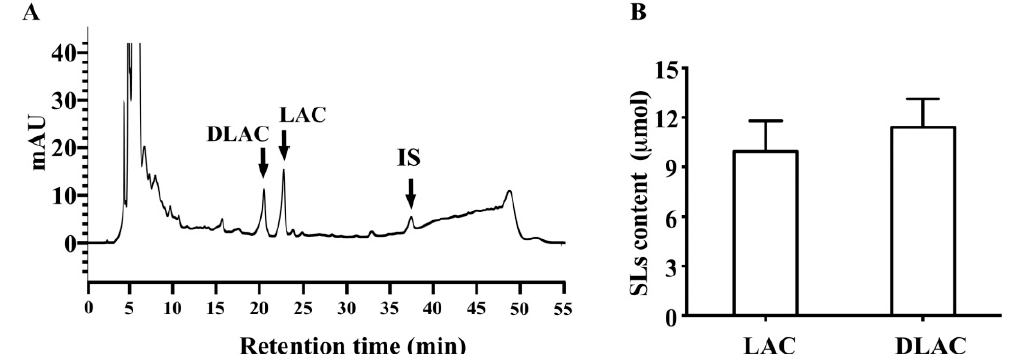
Figure 4. Characterization of sesquiterpene lactones in feces after Brussels / witloof chicory consumption. ( A ) Representative chromatographic profiles of free sesquiterpene lactones in human fecal sample collected in 24 h after the consumption of Brussels / witloof chicory. ( B ) Content of total sesquiterpene lactones in human fecal sample collected in 24 h after the consumption of Brussels / witloof chicory. LAC, lactucin; DLAC, 11 β ,13-dihydrolactucin; IS, internal standard.